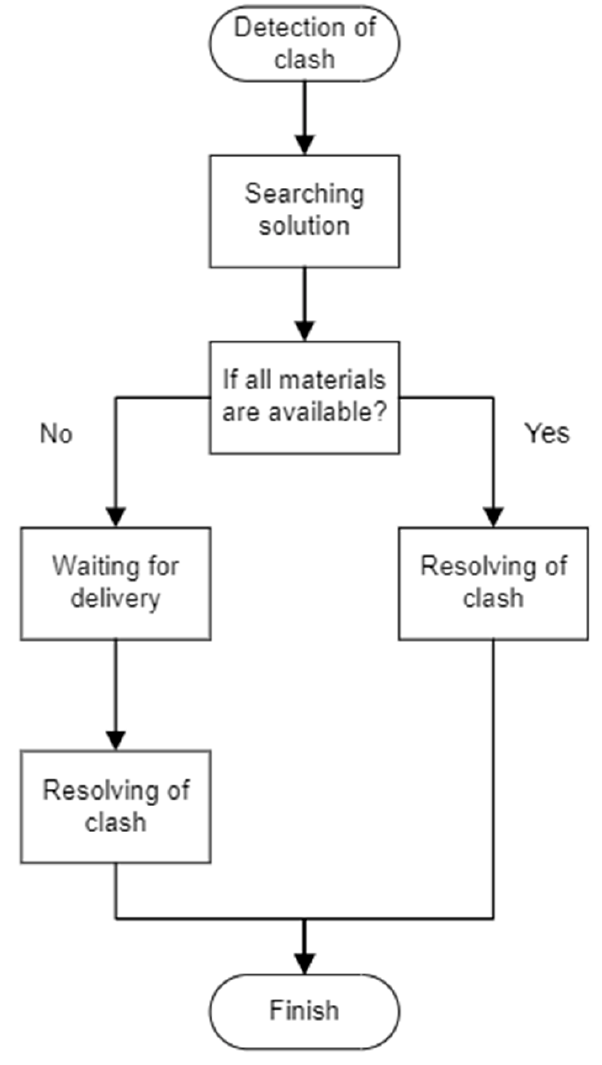
Figure 4. Minor clash workflow.